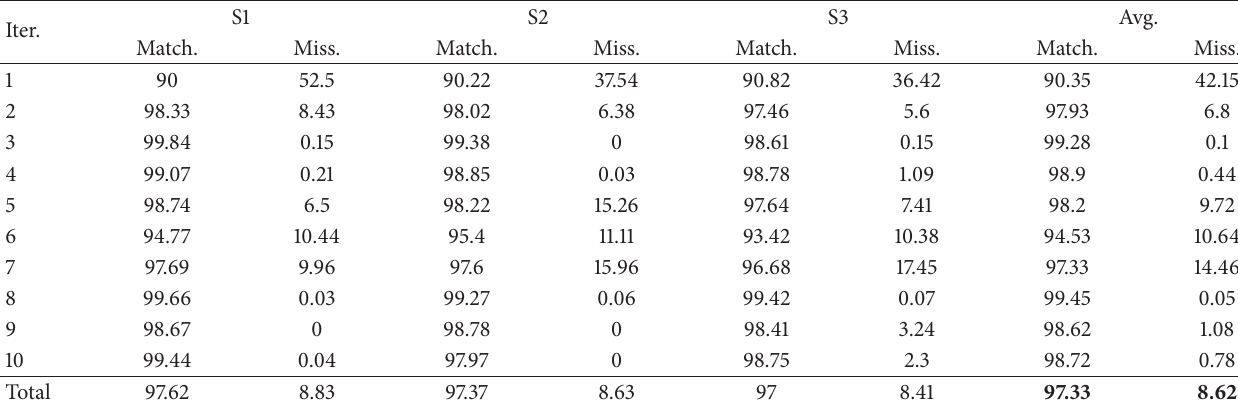
Table 3: Matching and missegmentation